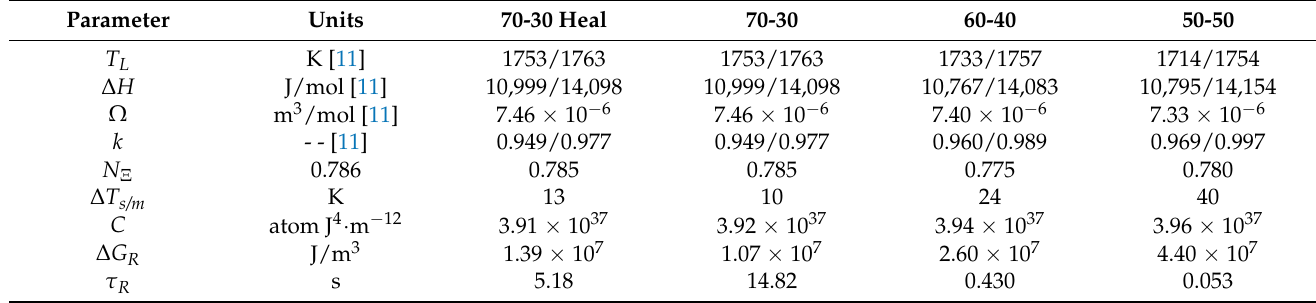
Table 1. Retained damage model parameters.